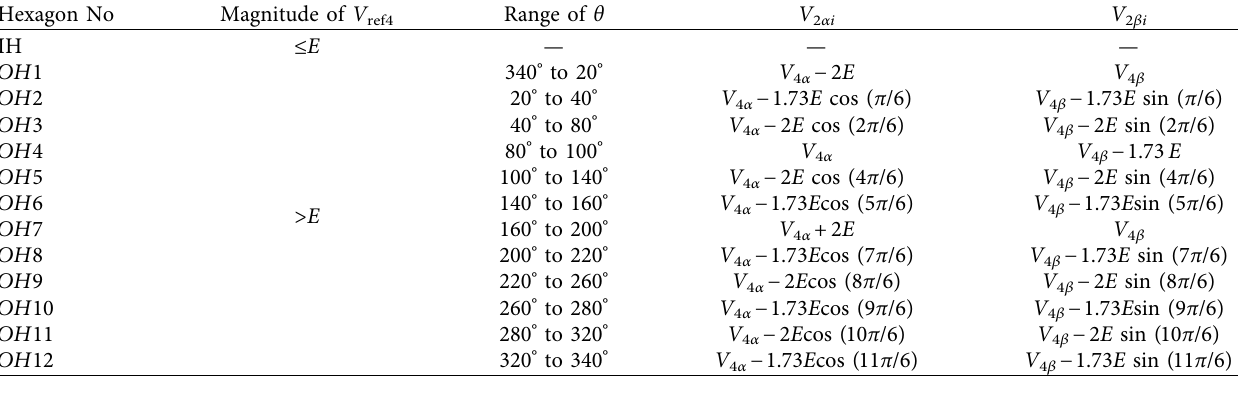
ref2 from V ref4 .